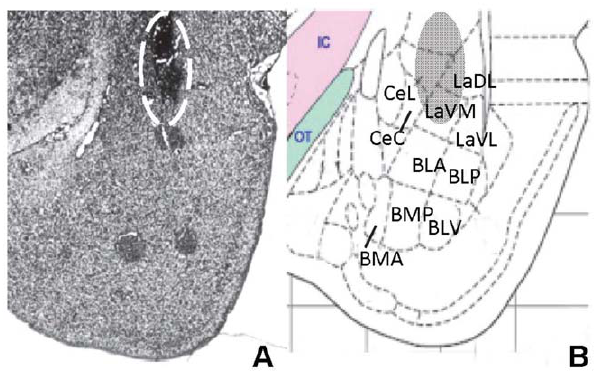
Figure 1. Histological verification of the location of the injection cannula in the lateral amygdaloid nucleus. A: